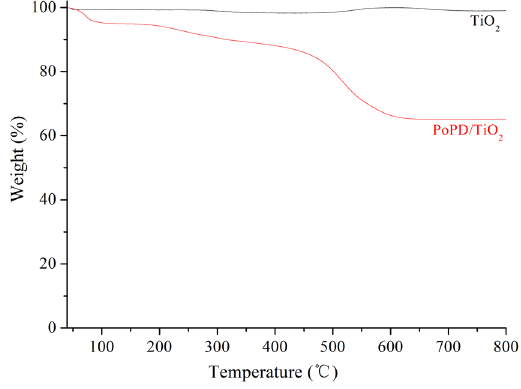
Figure 5. TGA curves of TiO 2 and